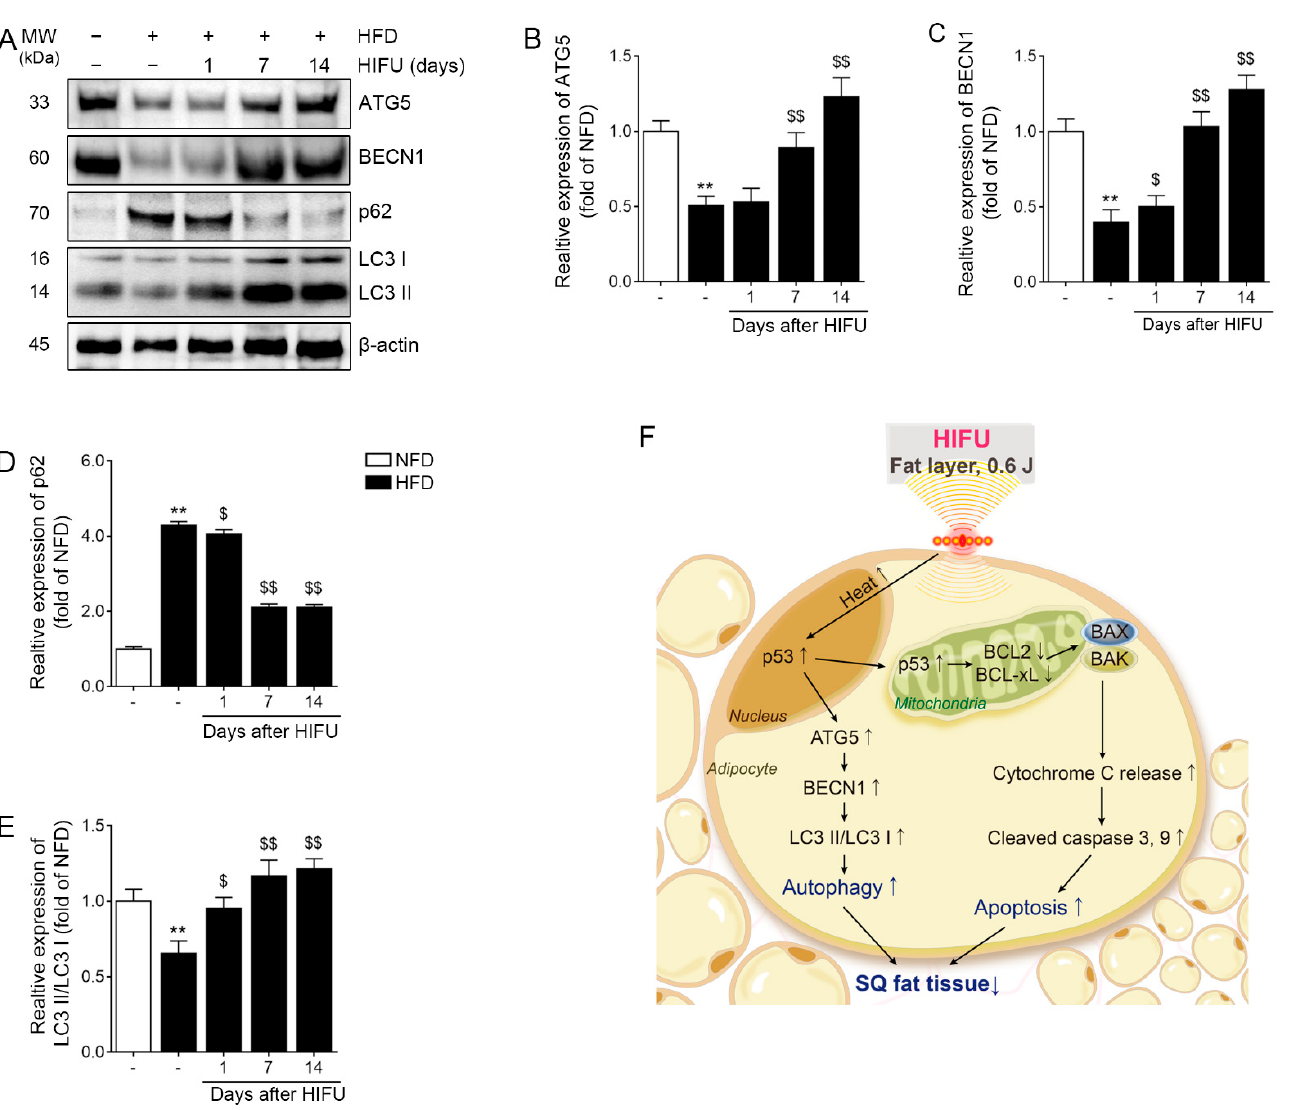
Figure 5. Regulation of autophagy in SAT after HIFU treatment. ( A ) The protein expression levels of autophagy-related markers were analyzed by western blot. ( B – E ) The quantitative graphs represent the results of the western blot analysis. The protein expression of ATG5 ( B ), BECN1 ( C ), and p62 ( D ), as well as the ratio of LC3II to LC3I ( E ), were regulated by HIFU treatment. ( F ) Summary of this study. The data are presented as the mean ± standard deviation; **, p < 0.01 HFD vs. NFD; $, p < 0.05 or $$, p < 0.01 vs. HFD (Mann–Whitney U test). ATG5, autophagy related 5; BECN1, beclin-1; HFD, high-fat diet; HIFU, high-intensity focused ultrasound; LC3, microtubule-associated protein 1A/1B-light chain 3; NFD, normal-fat diet; SAT, subcutaneous adipose tissue.